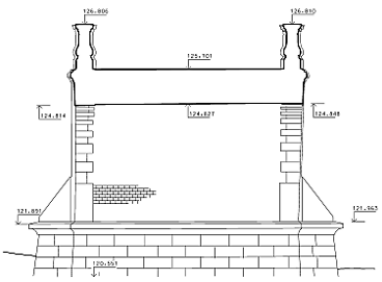
Figure 13. Detail of the polygonal model and the vector model